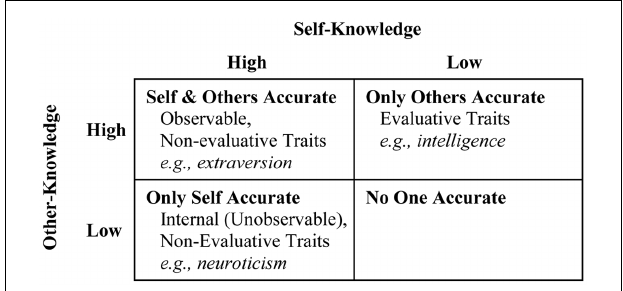
FIGURE 1 |The self-other knowledge asymmetry model, summarized fromVazire